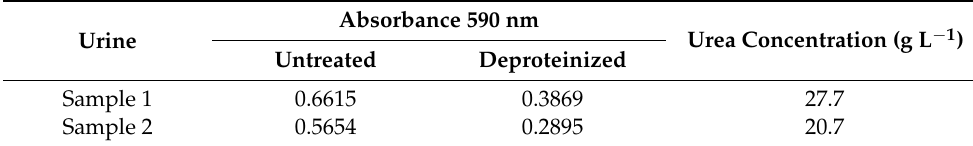
Table 4. Absorbance values for untreated and deproteinized urine samples and found urea concen- trations. Experimental scheme: direct urea → protein precipitation → sensor response.